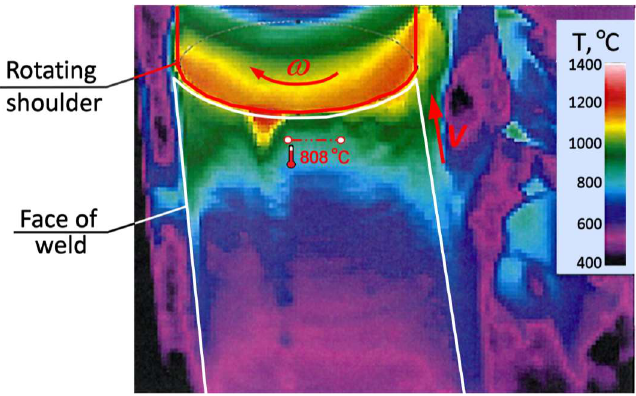
Figure 5. The temperature field ( T ) registered during FSW process by a thermal imaging camera on the copper plate surface behind the tool.